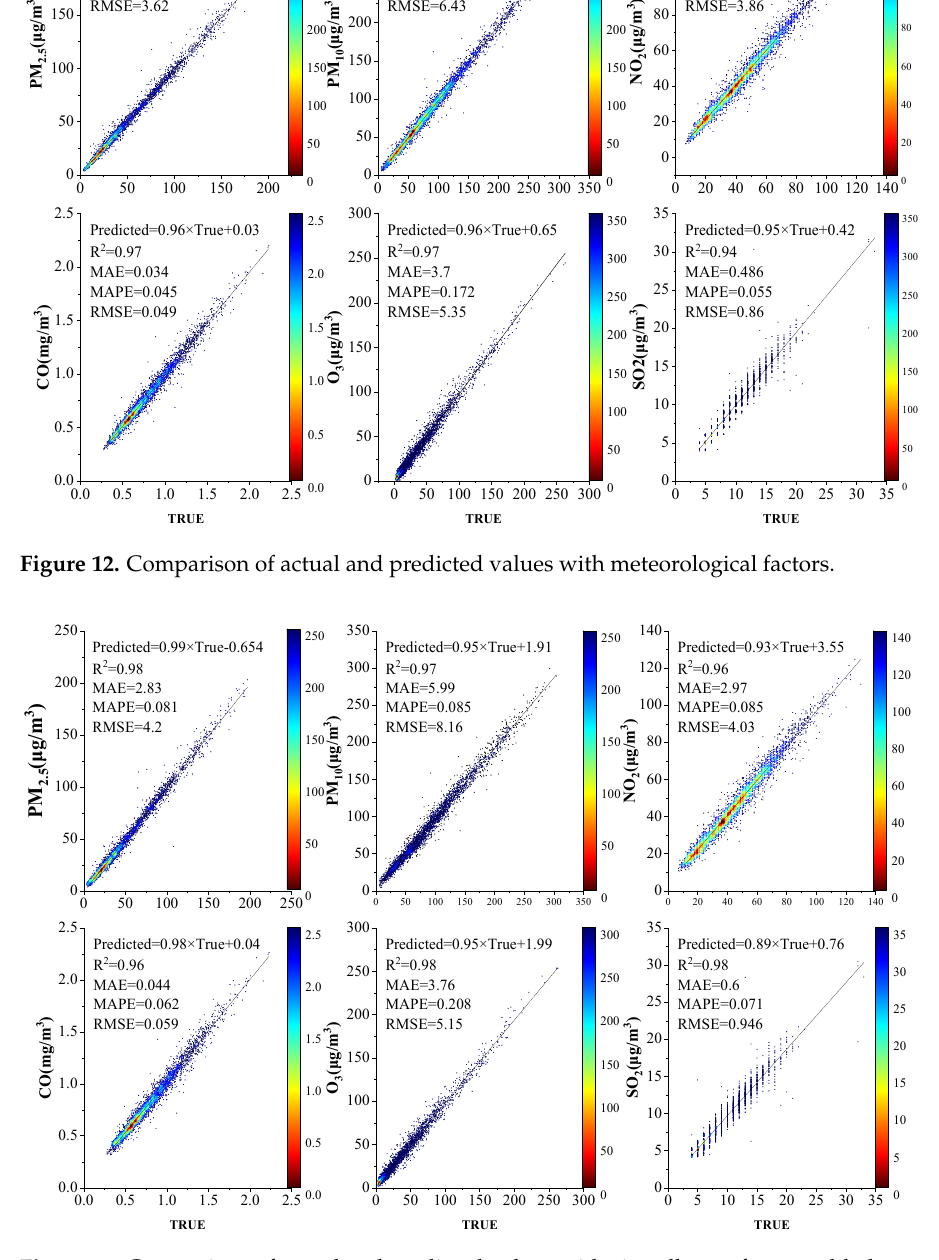
Figure 13. Comparison of actual and predicted values with air pollutant factors added.